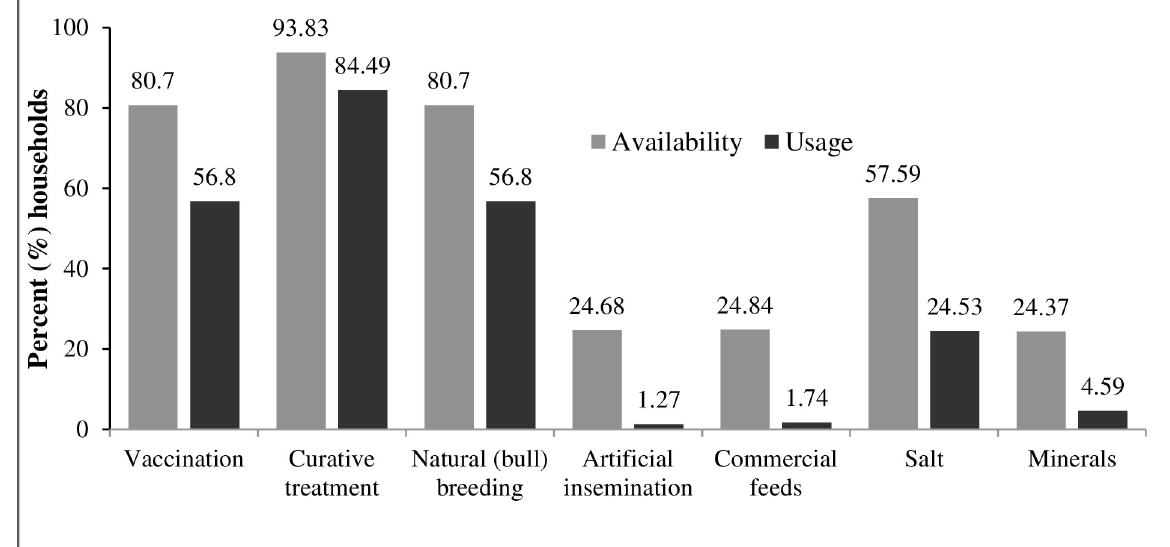
Fig 2. Availability and use of livestock management technologies in Kwale